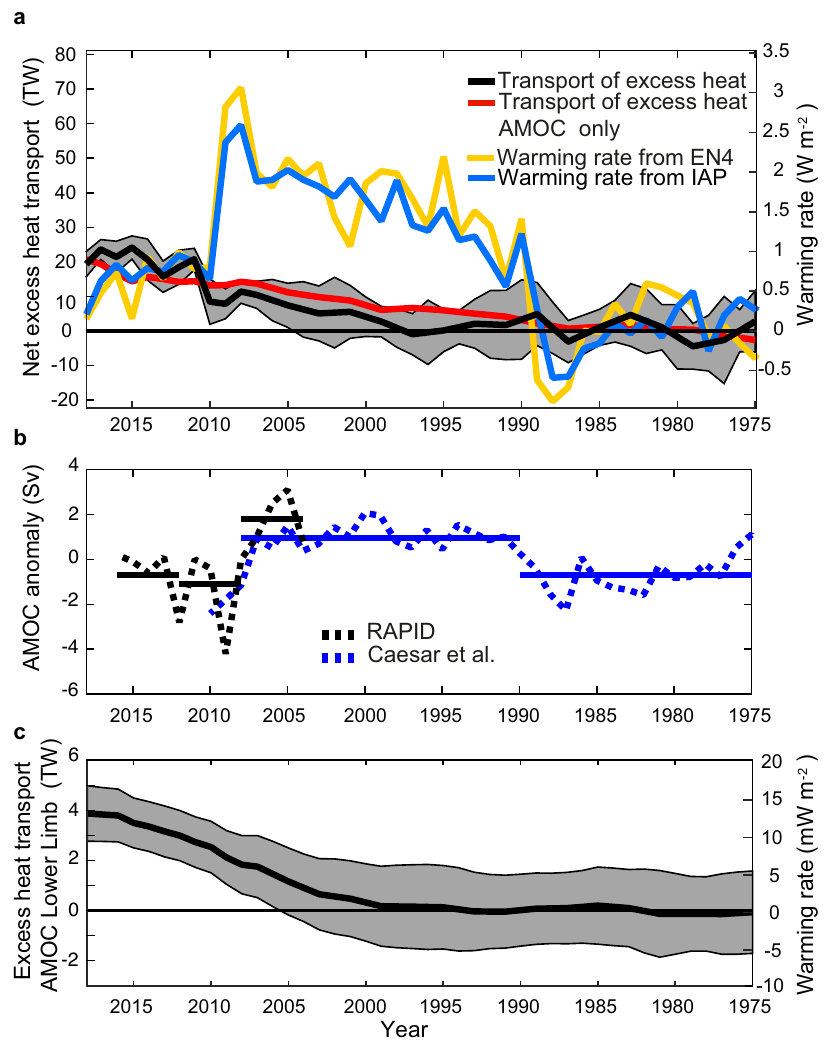
Fig. 6 Excess heat transport at 25°N and North Atlantic heat storage rates from climatologies. a Times series of Δ XHT (TW) due to the temperature- driven net transport of excess heat across 25°N (black line, positive northward). Δ XHT is also expressed as the equivalent heat fl ux per unit area for the region north of 25°N (W m − 2 ) and compared to the warming rate of the full-depth ocean heat content ( ∂ OHC ∂ t j ) over the domain between the north of > 25 N 25°N and Bering Strait (yellow = EN4 full depth, blue = IAP 0 – 2000 m completed by EN4 below). b Time series of the AMOC anomaly for 1975 – 2016, reproduced from Caesar et al. 90 (blue), and for 2004 – 2017, estimated by the in situ RAPID monitoring 60 . Caesar et al. ’ s time series is shifted by 5 years to account for the delayed response of Subpolar SST to AMOC variability at 25°N 91 . This shift realigns Caesar et al. ’ s time series with the 2009 AMOC drop observed at RAPID. The thick continuous lines show the mean values for different time periods identi fi ed as relevant to AMOC state changes. c Times series of Δ XHT due to the temperature-driven transport in the AMOC lower limb (depth >1000 m, positive southward), also shown as warming rate (mW m − 2 ) when applied over the world ocean surface area at 1000m, excluding the Atlantic sector north of 25°N. Both Δ XHT time series are relative to 1975 – 1986 mean. The grey shading in ( a ) and ( c ) shows the one standard deviation of Δ XHT estimated from the 5005-member ensemble computed using the fi ve different cruises and 1001 different SSTs ( ‘ Methods ’